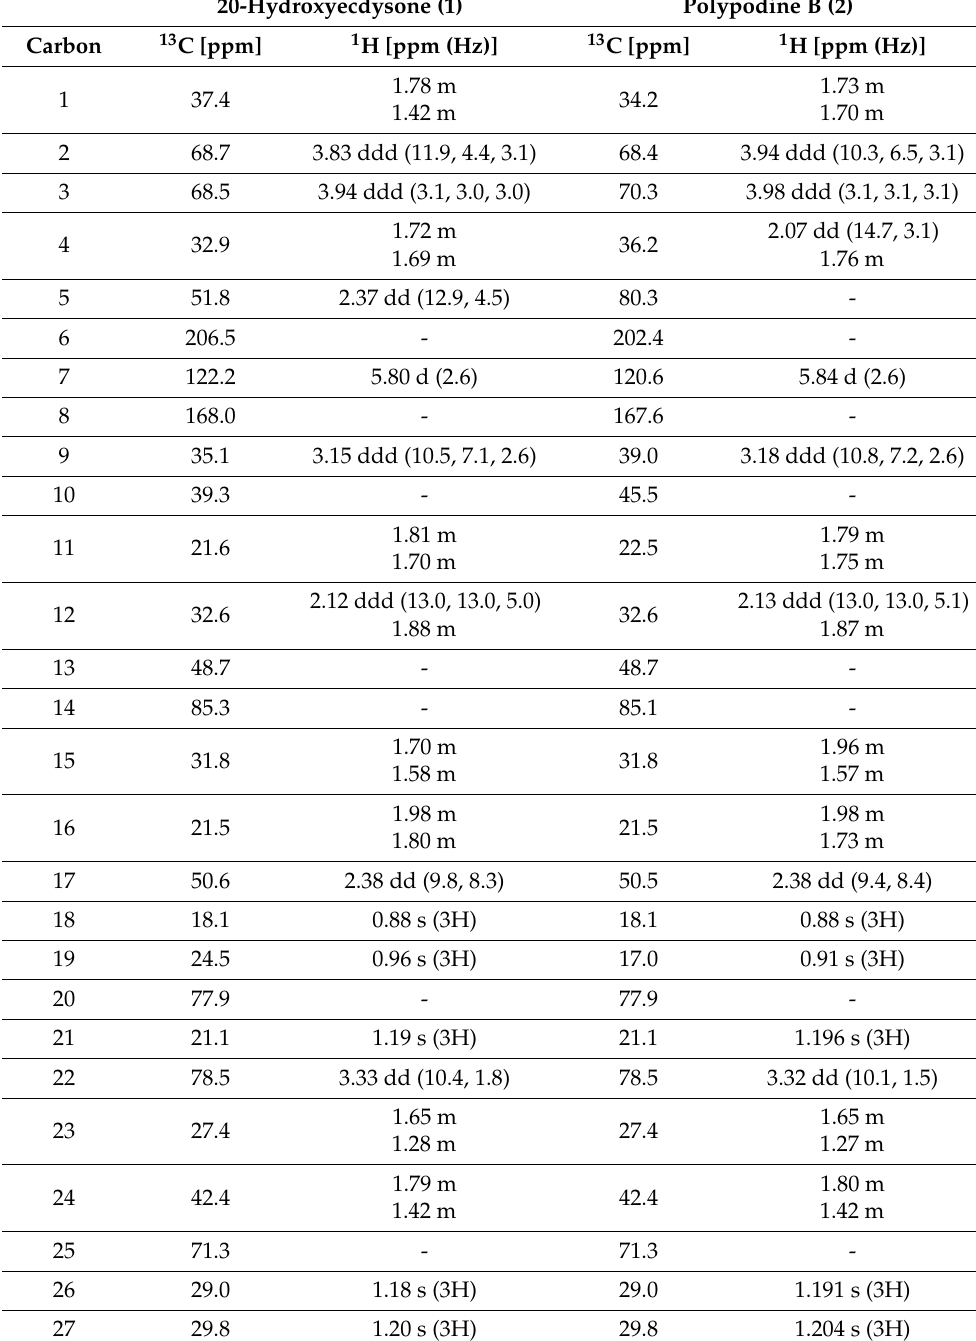
Table 1. NMR spectral data of compounds 1 and 2 (in CD 3